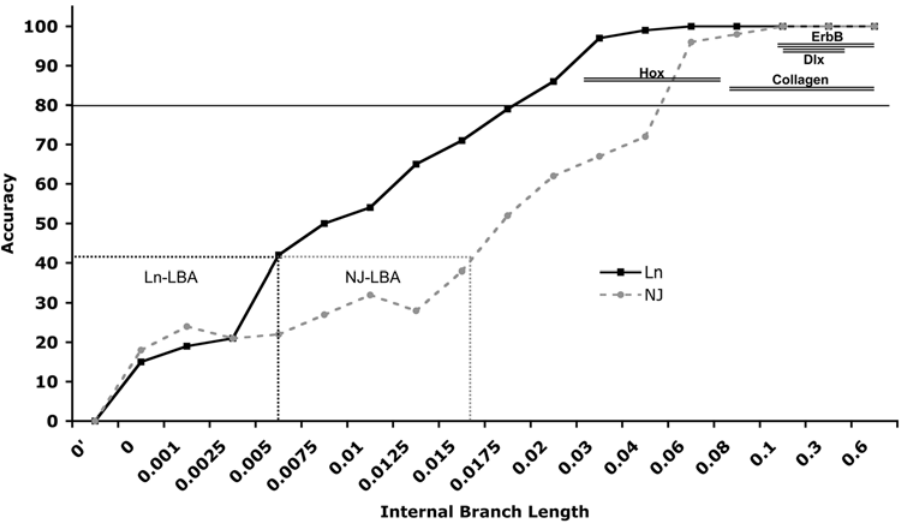
Figure 3. Accuracy plot. Results from the simulation study analyzing the effects of branch length on accuracy of tree inference. The internal branch length of the simulated data (X-axis) is plotted against the accuracy (Y-axis) of the inferred trees. The branch lengths that show strong long-branch attraction (LBA) biases are boxed (dashed-line) and labeled. The range of internal branch lengths for each gene family is plotted against the average internal branch support for that family obtained from phylogenetic analyses of real data shown in Figure 2 (shown as double lines). Note that branch lengths for each gene are well outside the range expected to be influenced by LBA and support is greater than 80% of bootstrap replicates (solid black line).